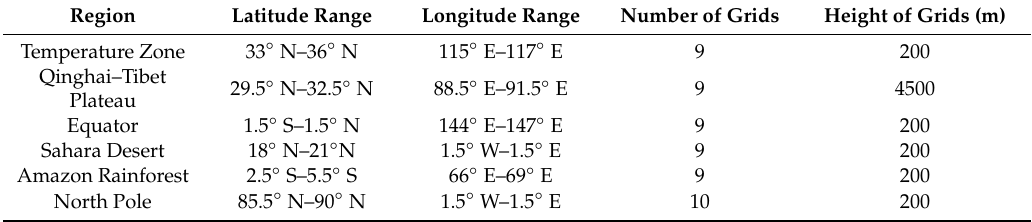
Table 1. The six regions and coordinates in the scheme (the notations “N”, “S”, “E”, and “W” indicate northern latitude, southern latitude, eastern longitude, and western longitude, respectively).